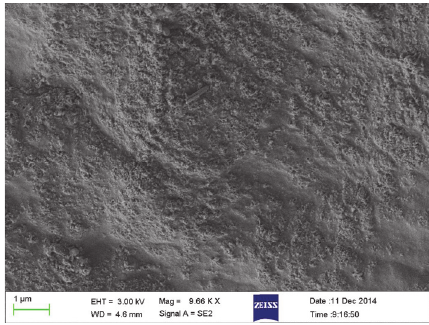
Figure 7: SEM spectrum of immobilized PU/TiO 2 .